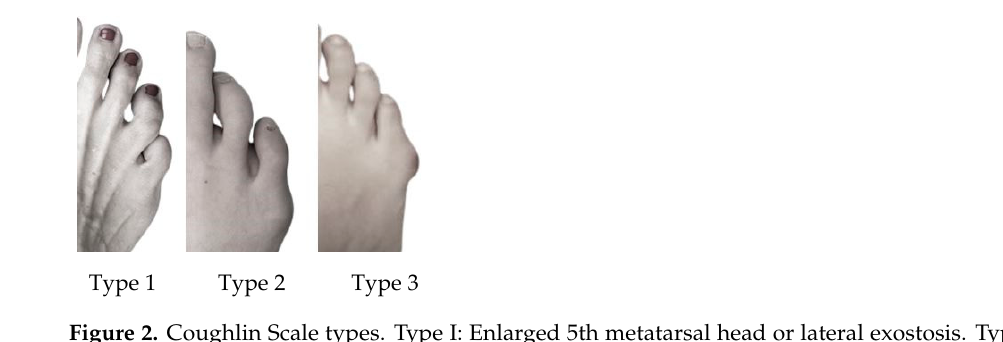
Figure 2. Coughlin Scale types. Type I: Enlarged 5th metatarsal head or lateral exostosis. Type II: Congenital bow of 5th metatarsal, normal 4th–5th intermetatarsal angles. Type III: Increased 4th and 5th intermetatarsal angle.